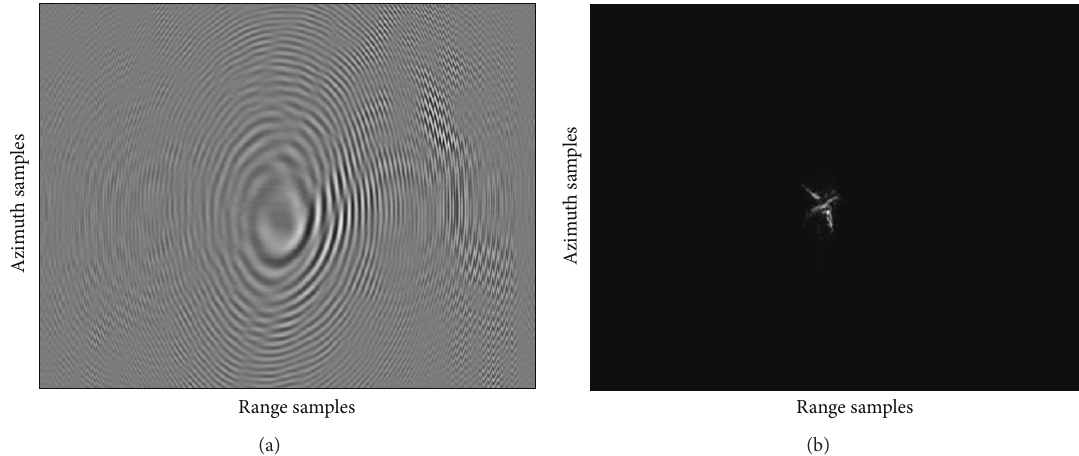
Figure 13: The simulated echo (a) and image (b) results of the plane model in the case of high- speed.